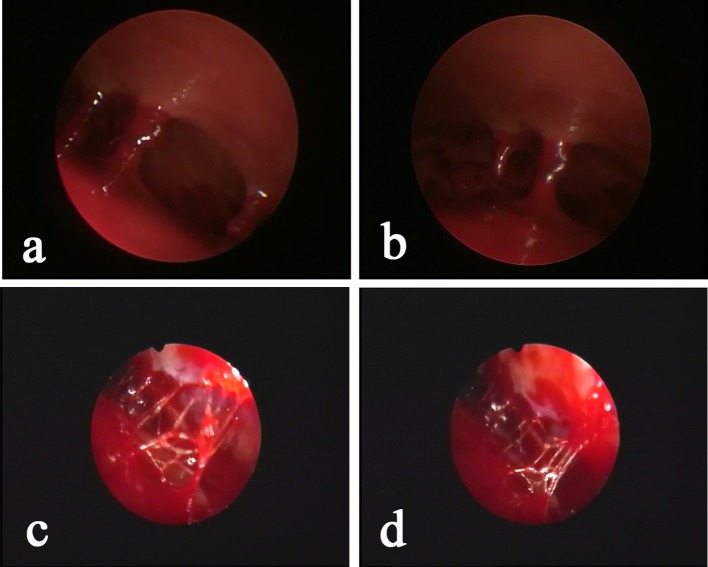
Neuroendoscopic observation of the hematoma with “separation,” as determined by pre-operative CT, shows that the “separation” is mainly a separation lock column (a,b) or separation strip (c,d) instead of a real closed septum. The relative separation is sufficient to block the blood clot in the chamber. Conventional BHD is not sufficient to completely drain the hematoma, but INET is able to remove the separation strip or separation lock column and visually clean the old blood clots.